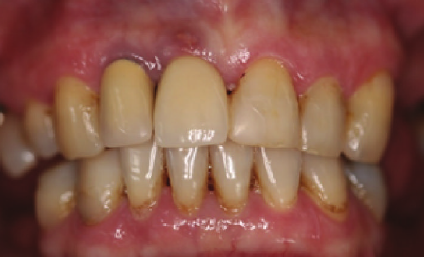
Figure 1: Initial clinical view of the patient with Sjogren’s syndrome (August 2008).